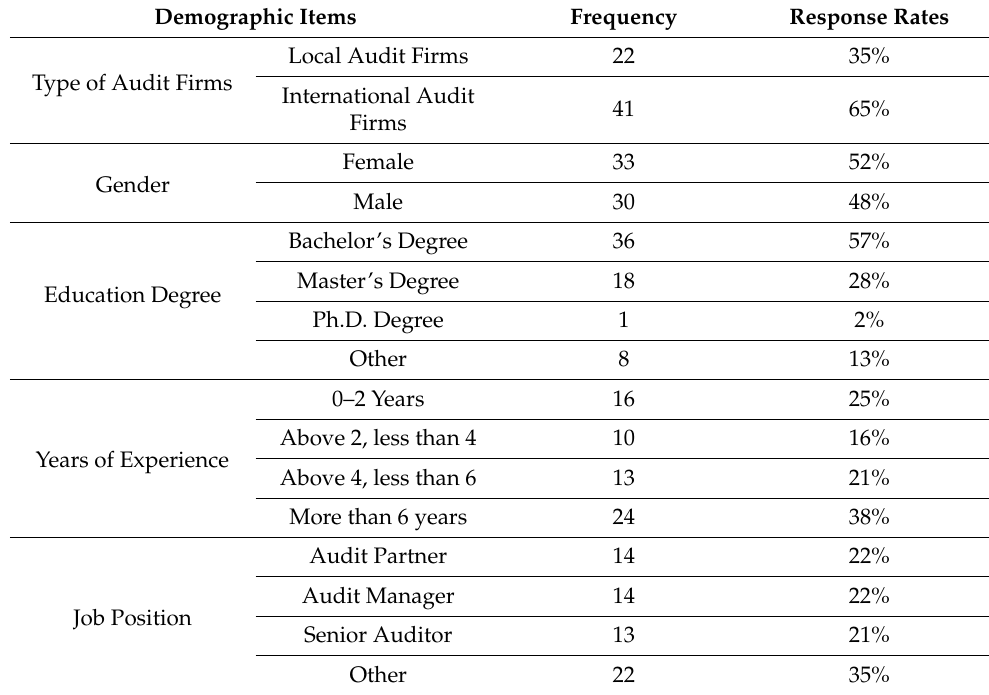
Table 3. Items for demographics.